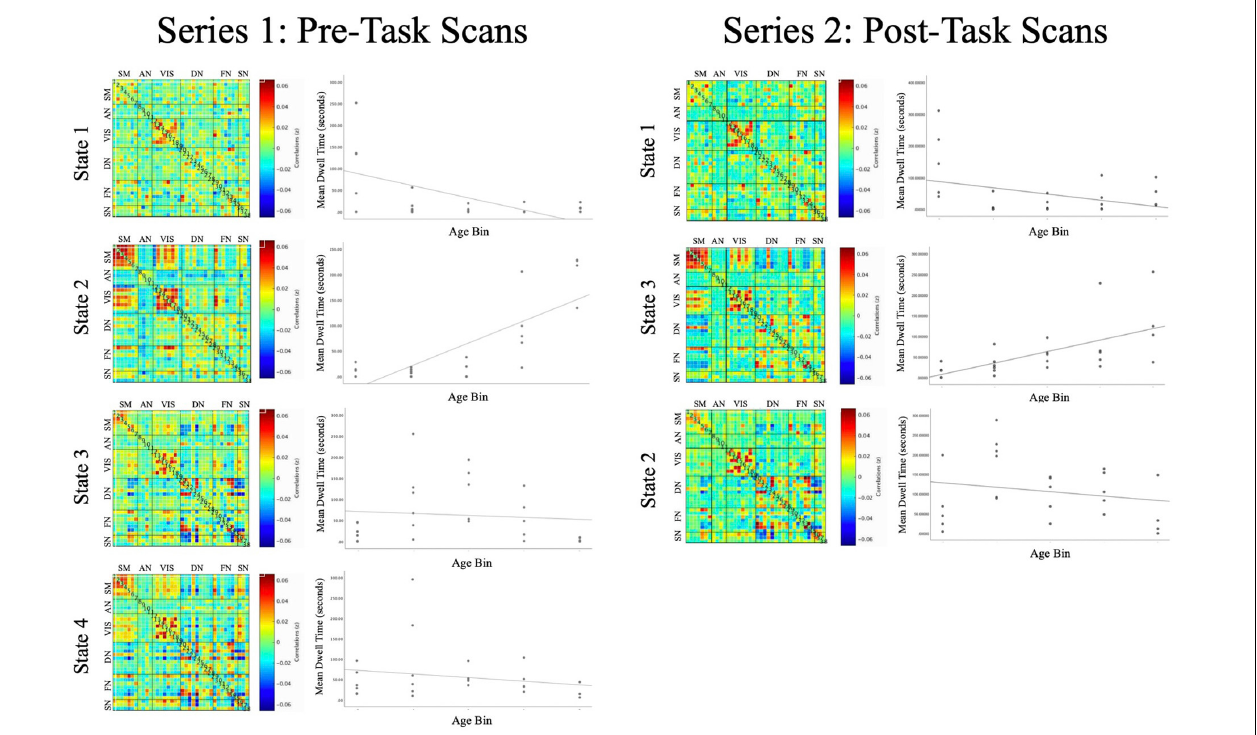
FIGURE 4 | Each of the intrinsic functional connectivity states are organized into a correlation matrix, with ROIs grouped by functional domain for pre-task (left) and post-task (right) functional runs. Scatterplots depict the association between Age and Mean Dwell Time for each of the ICN states. State 2 (left) and State 3 (right) exhibited similar profiles of connectivity, with Mean Dwell Time tending to increase across the lifespan [ t (20) = 3.780, p = 0.001; t (19) = 3.326, p =